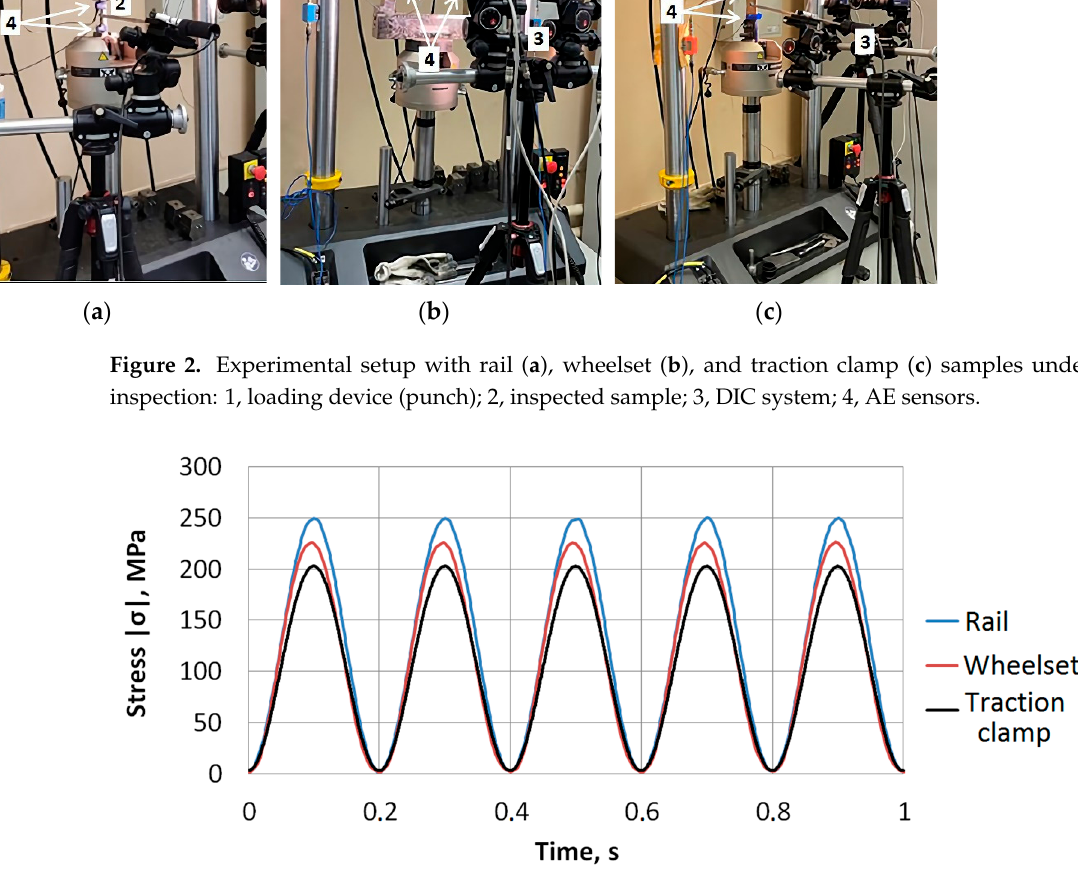
Figure 3. Loading cycles applied to the inspected samples. Table 3. Loading conditions applied to the samples.